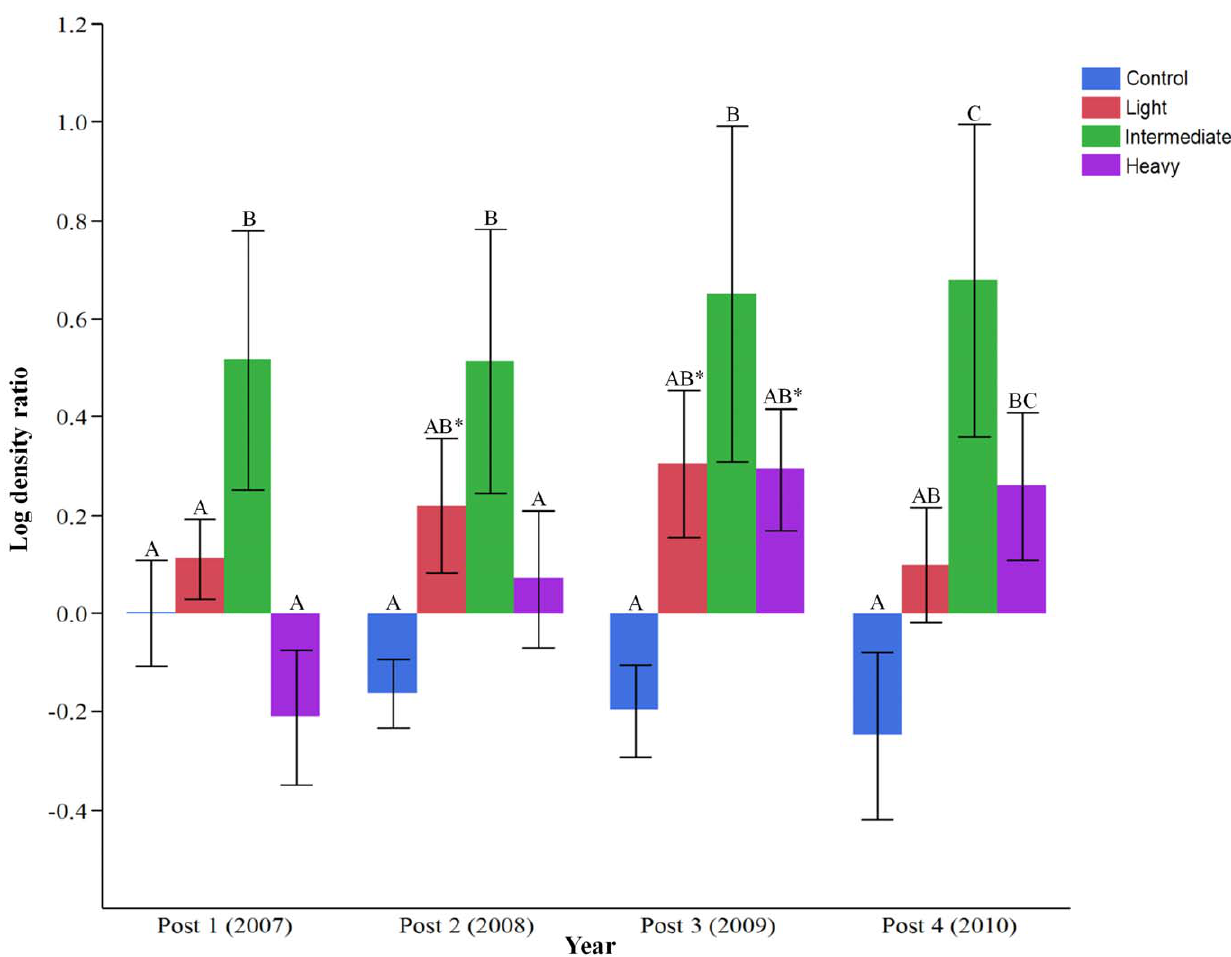
Figure 3. Breeding density ratio (post/pre-disturbance, log-transformed) of cerulean warblers on plots disturbed by various intensities of timber harvest. Log density ratio=0 reflects no change in density; all values above 0 indicate increased density, all values below indicate density reduction. Different letters indicate significant differences ( P # 0.05) among respective treatments for a given year, based on independent contrasts. Asterisks indicate marginal differences (0.05 , P # 0.10) between respective treatment and control for a given year. Error bars represent 6 1 SE.